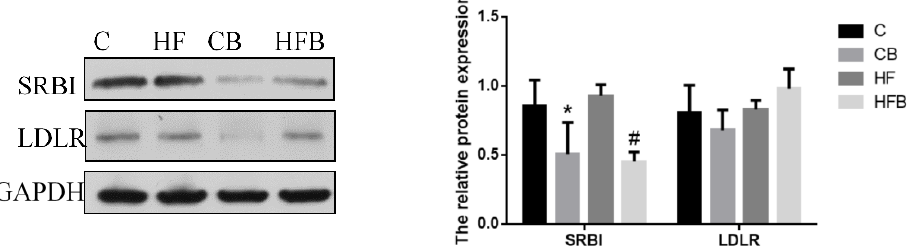
Figure 7. Effects of betaine and high-fat diet on protein expression of hepatic LDLR and SRBI in rats ( n = 8). SRBI, class B scavenger receptor (BET, p < 0.001, FAT, p = 0.918, interaction, p = 0.475). LDLR, low-density lipoprotein receptor (BET, p = 0.839, FAT, p = 0.011, interaction, p = 0.027). * Significantly different from the C group ( p < 0.05). # Significantly different from the HF group ( p < 0.05). C—basal diet, CB—basal diet supplemented with 1% betaine, HF—high-fat diet, HFB—high-fat diet supplemented with 1% betaine.